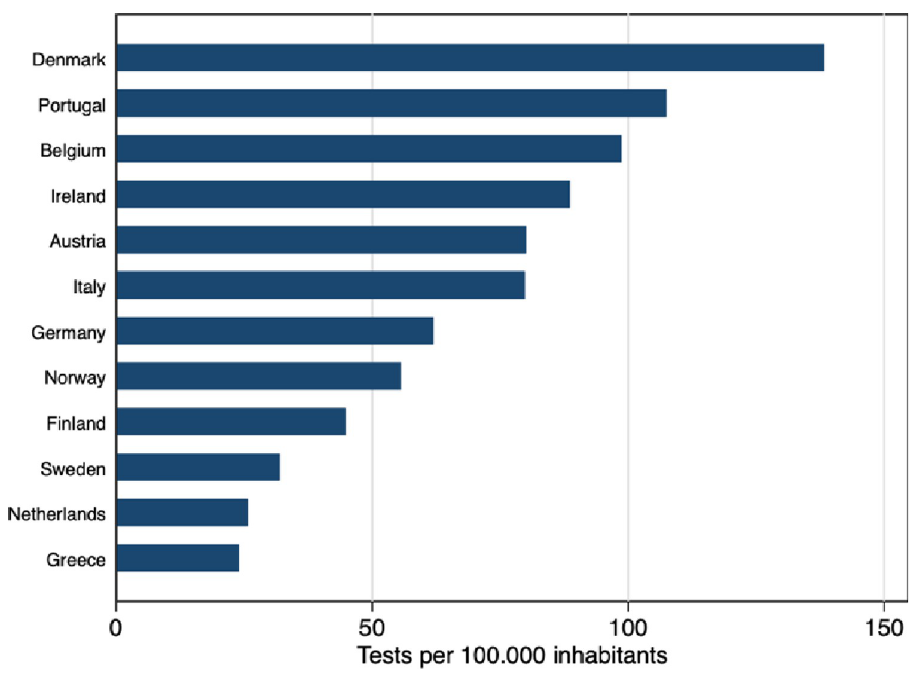
Fig 1. Number of tests in 12 European countries. Notes : The figure shows the average number of tests per 100,000 inhabitants in 12 European countries between March 15 and May 30. Data source: ECDC.